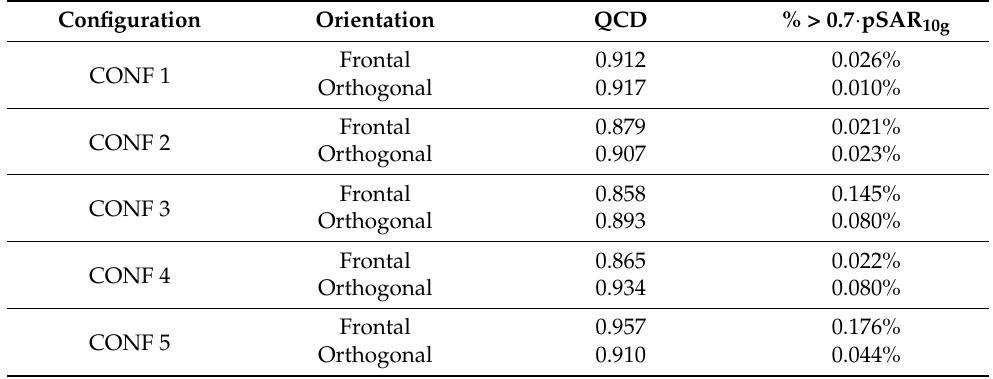
Table 3. QCD and percentage of values higher than 0.7 pSAR 10g of each configuration for the whole brain.